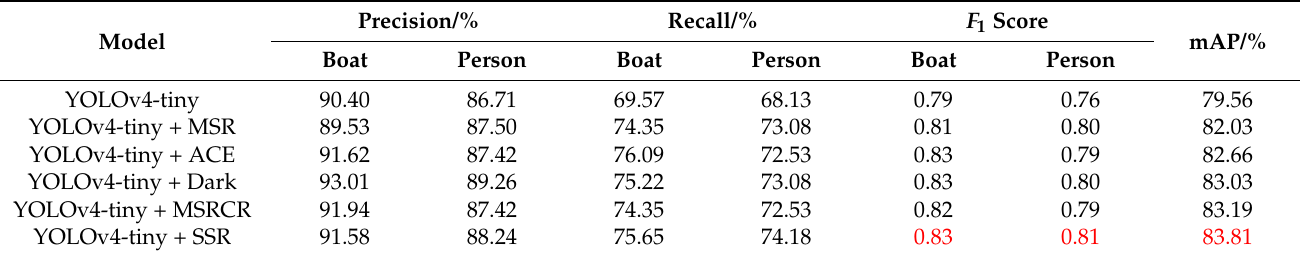
Table 2. Experimental results of various dehazing algorithms.